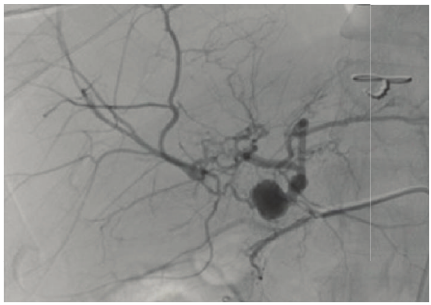
Figure 1: Hepatic angiography showing right hepatic artery aneurysm(1.2 × 1.0cm)andlefthepaticarteryaneurysm(5 × 6 mm).